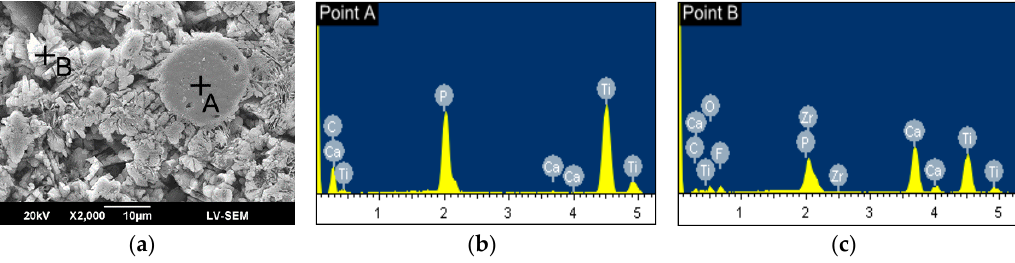
Figure 8. ( a ) SEM metallograph showing microstructure of CL in FA/ZrO 2 specimen prepared using P = 1200 W and V = 600 mm/min; ( b ) EDS analysis results for particle A in ( a ); and ( c ) EDS analysis results for particle B in ( a ).